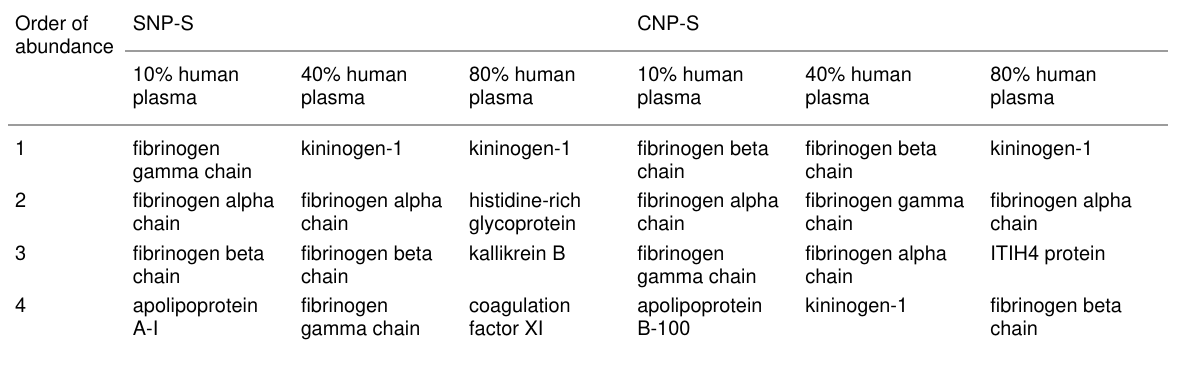
Table 4: Top 20 most abundant proteins in small silica (SNP-S) and carbon (CNP-S) nanoparticle hard corona samples at three different plasma con- centrations (10, 40, 80%) based on the LFQ intensity. Order of abundance